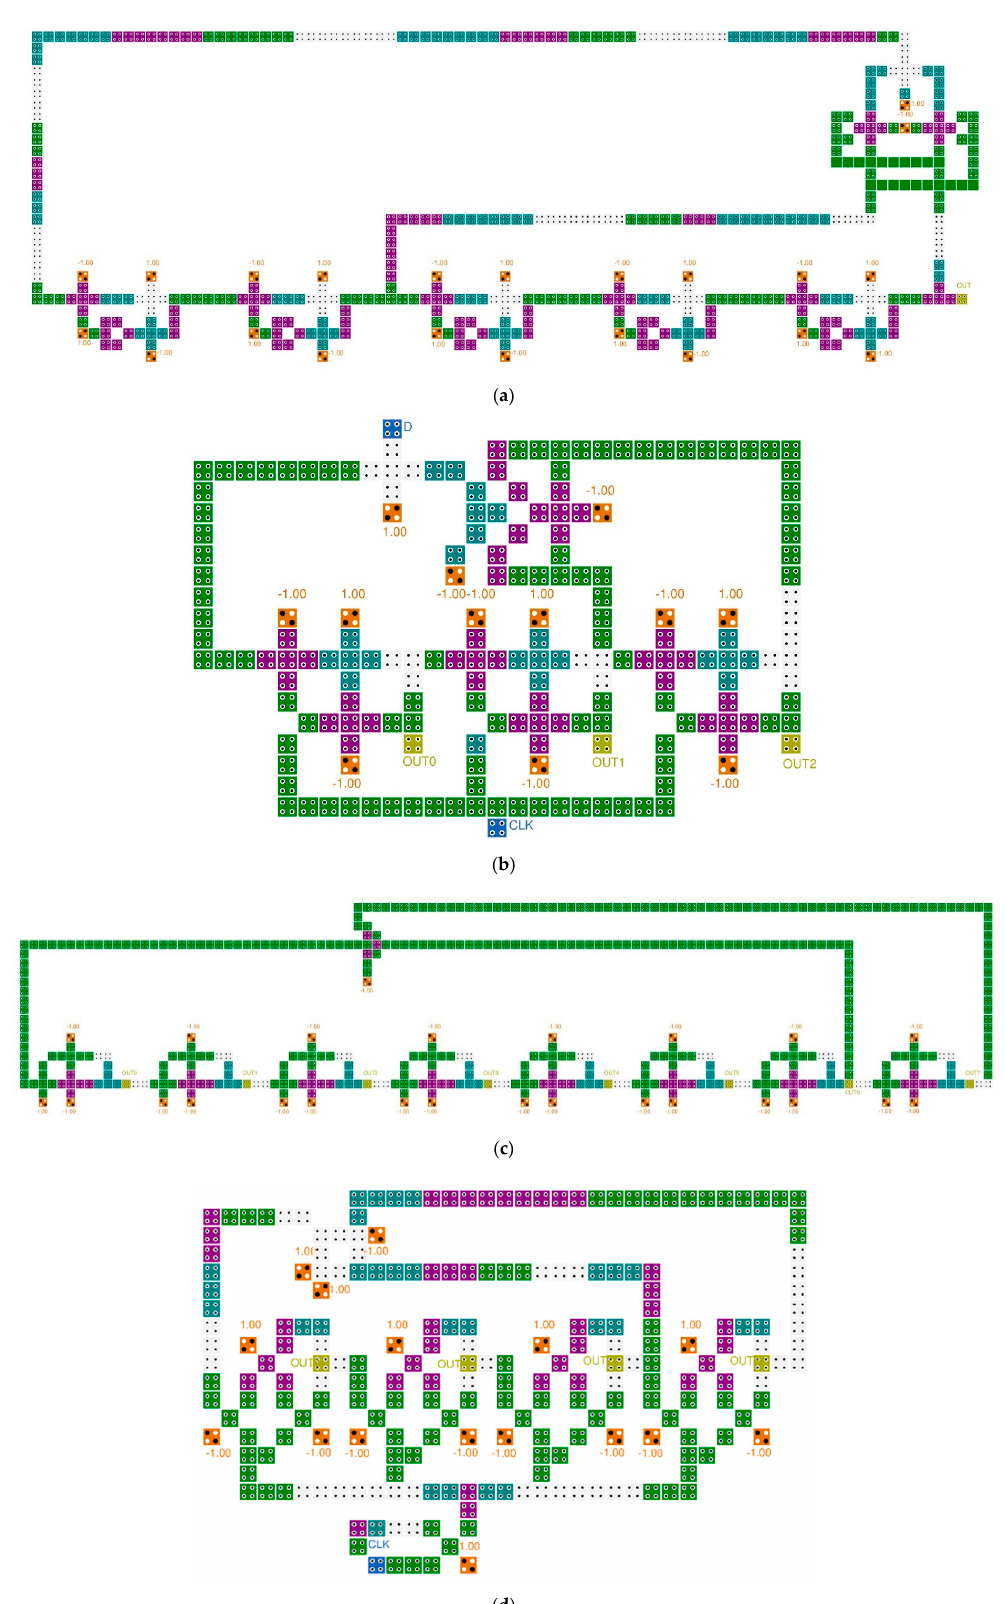
Figure 9. Typical LFSR structures: ( a ) A. Rezaei et al.’s [36]; ( b ) H. Mohammadi et al.’s [37]; ( c ) M. Kaviya et al.’s [38]; and ( d ) Z. Amirzadeh et al.’s [39].